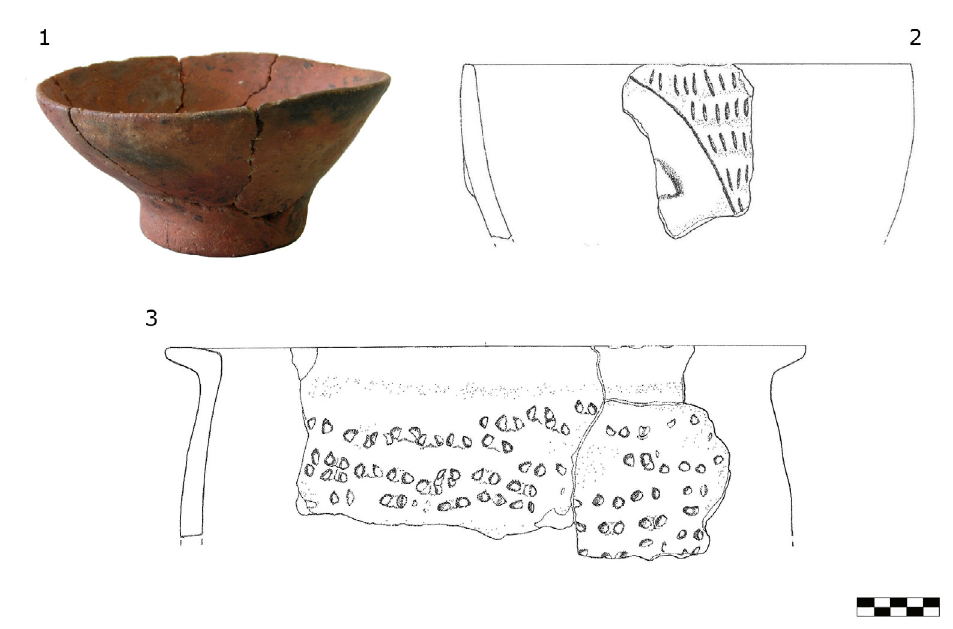
Figure 6. S. Martino. Stentinello pottery. Coarse Impressed Ware class (bowls and large jar).